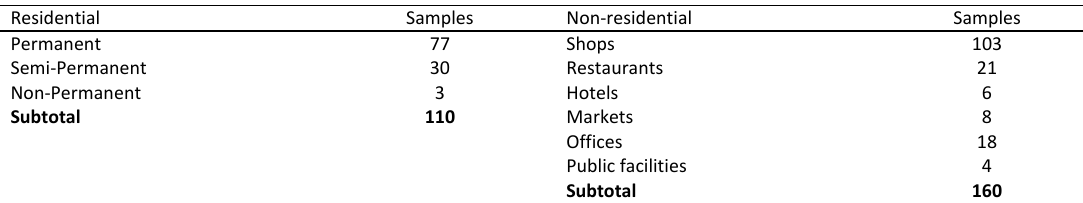
Table 1: Table 1: Residential and non-residential samples